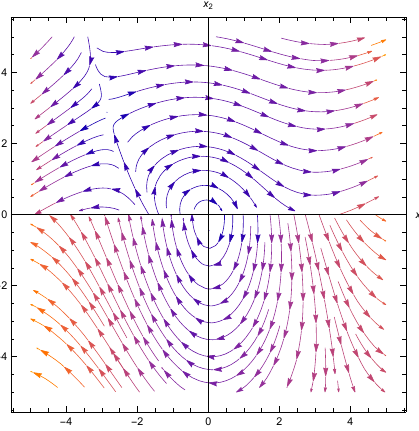
Figure 5. Local phase portrait of (52) for ε = 0.1, µ 1 = µ 2 = 1 and h ( x 1 ) = x 1 + x 3